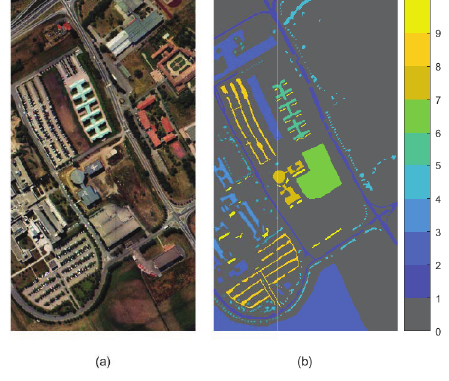
Figure 5. Pavia University dataset. ( a ) False color image. ( b ) Ground